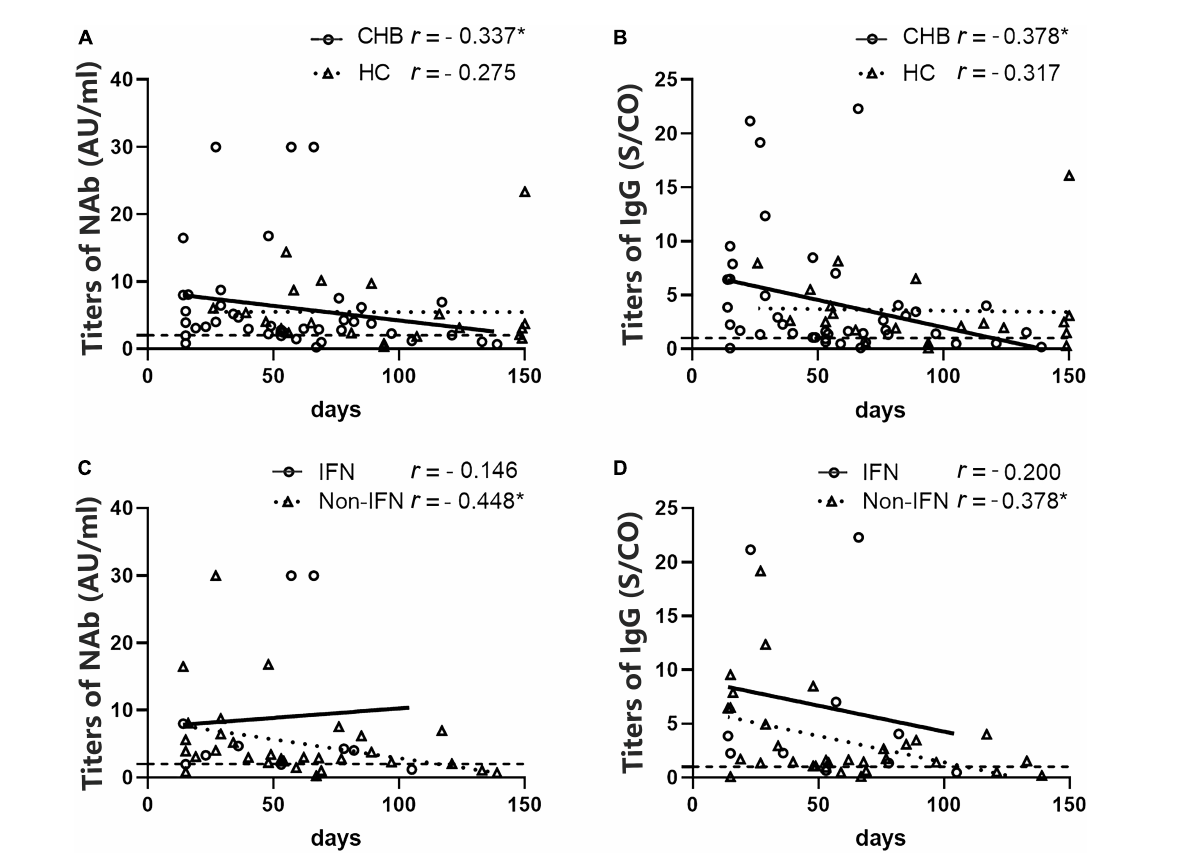
FIGURE6 Analysis of the correlation between antibody titers and the number of days after the second vaccine dose in patients with CHB and HCs. (A,B) A negative correlation between NAb and immunoglobulin G (IgG) titers and the number of days after the second dose was observed in patients with CHB but not in HCs. (C,D) A negative correlation between NAb and IgG titers and the number of days after the second dose was observed in the non-IFN group of patients with CHB but not in the IFN group. * P < 0.05; the IFN group, patients with CHB receiving nucleos(t)ide analogs (NAs) combined with Peg-interferon-alpha therapy; the non-IFN group, patients with CHB receiving NAs monotherapy; n1/n2 in bars, positive cases/all cases; dotted line, cut-off value; CHB, chronic hepatitis B; HCs, healthy controls; NAb, neutralizing